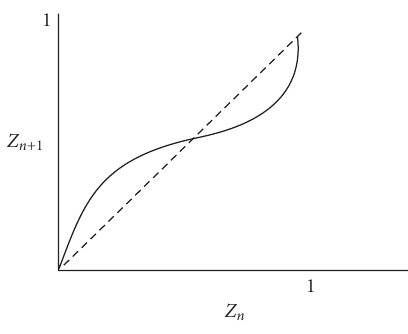
Figure 2.1. The graph of f in the simplest case. The model: mimic ratio will tend to an optimal value.